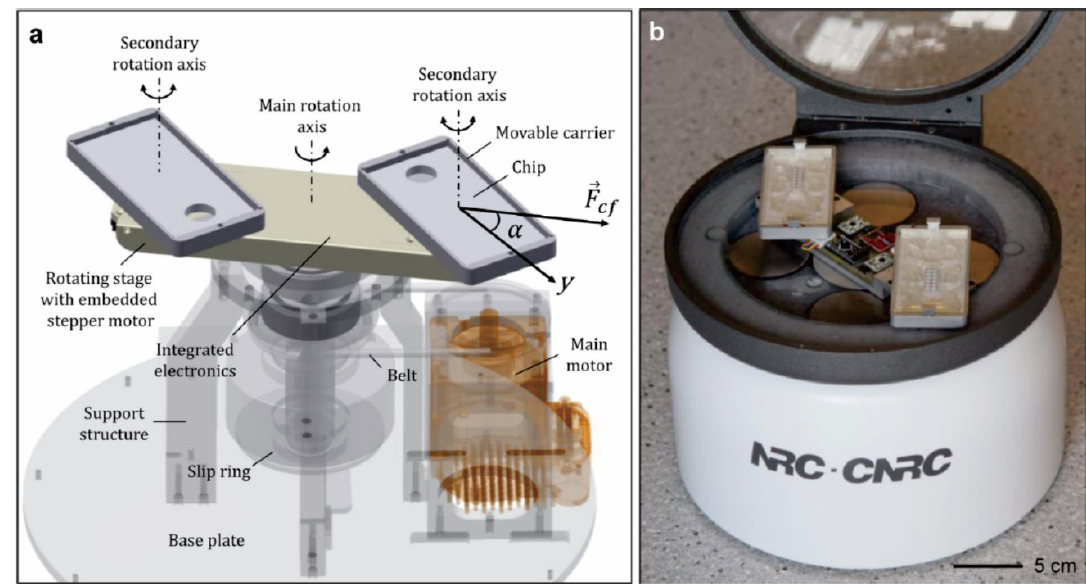
Figure 9. Articulated centrifugal platform. Figure reprinted with permission from [101].